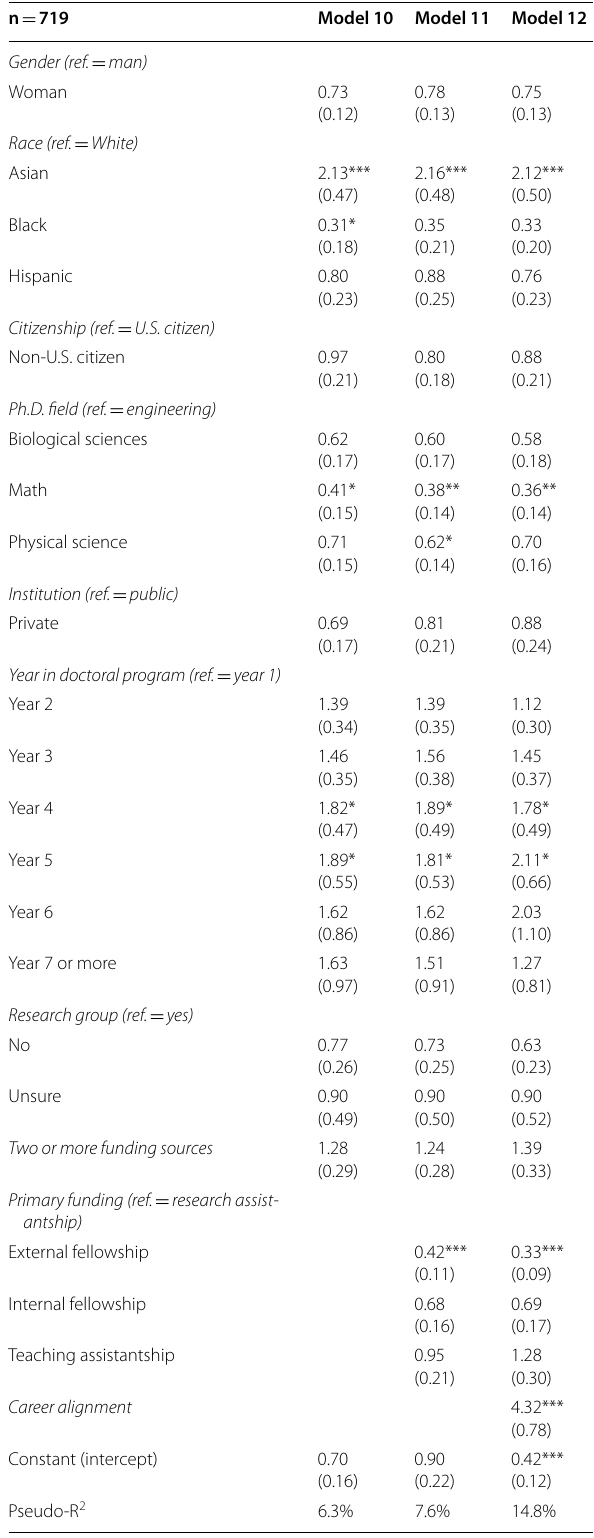
Table 7 Logistic regression of communication